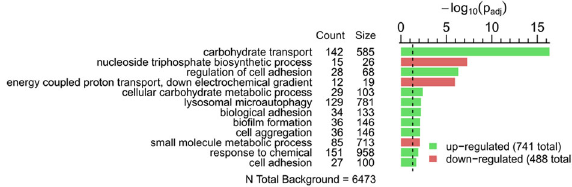
Fig. 5 GO term analysis of differentially expressed genes in 8 h wild-type bio fi lms grown under hypoxia vs. normoxia. Enriched GO terms were determined for hypoxia up-regulated genes (741 total) and hypoxia down-regulated genes (488 total) in contrast to the normoxic counterparts. Count describes the number of measured differentially regulated genes of a process (cluster frequency) and size measures the genomic background frequency. All GO terms were summarized using REVIGO with stringent settings (Cutoff: 0.7 dispensability). Source data are provided as a Source Data fi